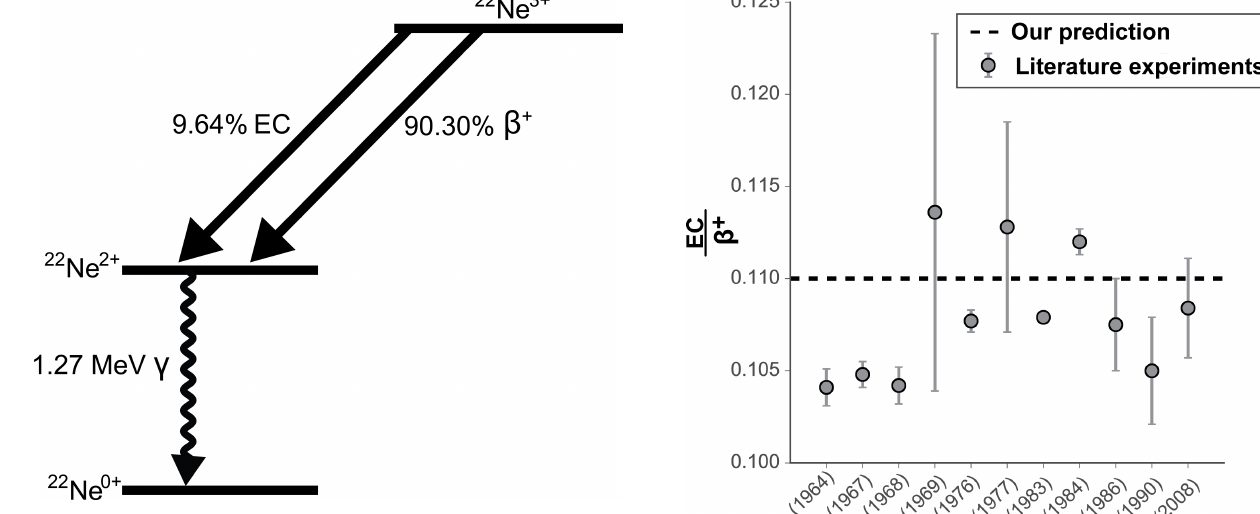
Figure 3. Decay scheme of 22 Na following Bé et al. (2010) and Leutz et al. (1965). An additional EC and β + decay pair that cor- responds to approximately 0.056% of the total decay of 22 Na has been omitted for clarity.